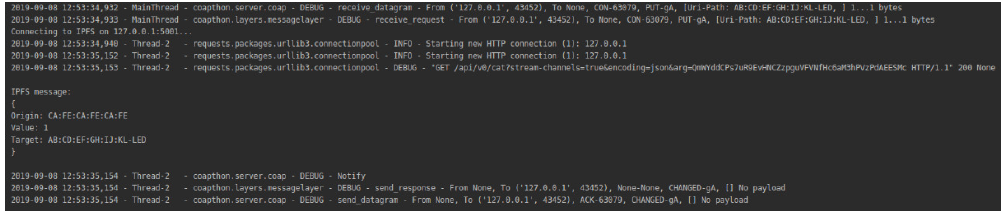
Figure 10. IPFS storage process.